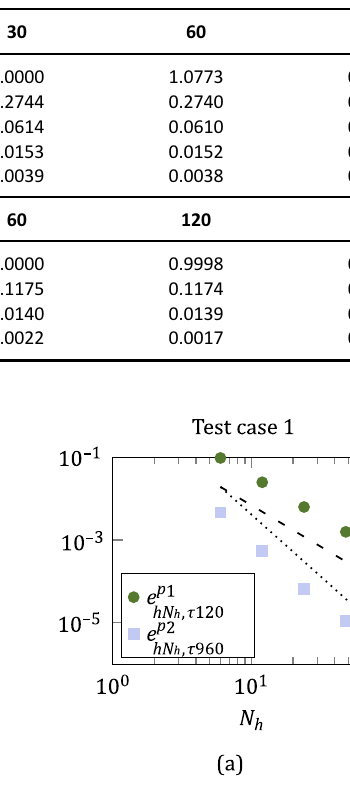
Figure 7. Spatial convergence with manufactured solutions , cf. section Convergence tests . The error e pcg Test Case 2 (b) for suf fi ciently fi ne time discretizations N s , for varying space discretizations N h , and for linear and quadratic shape functions. The dashed lines indicate the slope of a quadratic convergence the dotted lines indicate a convergence of order